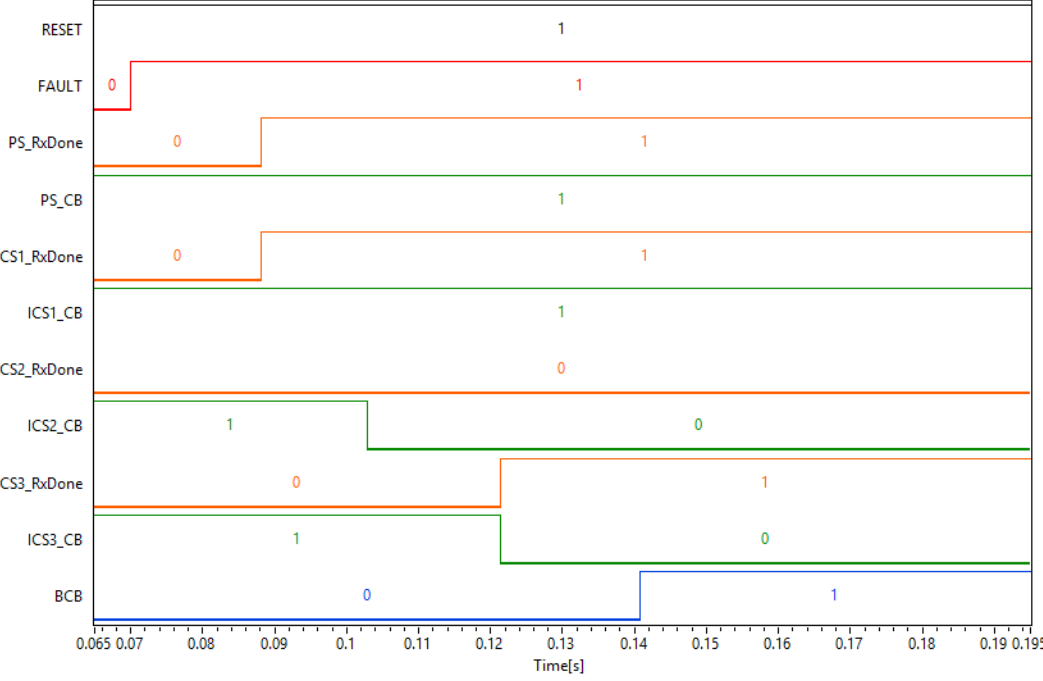
Figure 13. Digital signals acquired during the fault 50.S3 between PR2 and